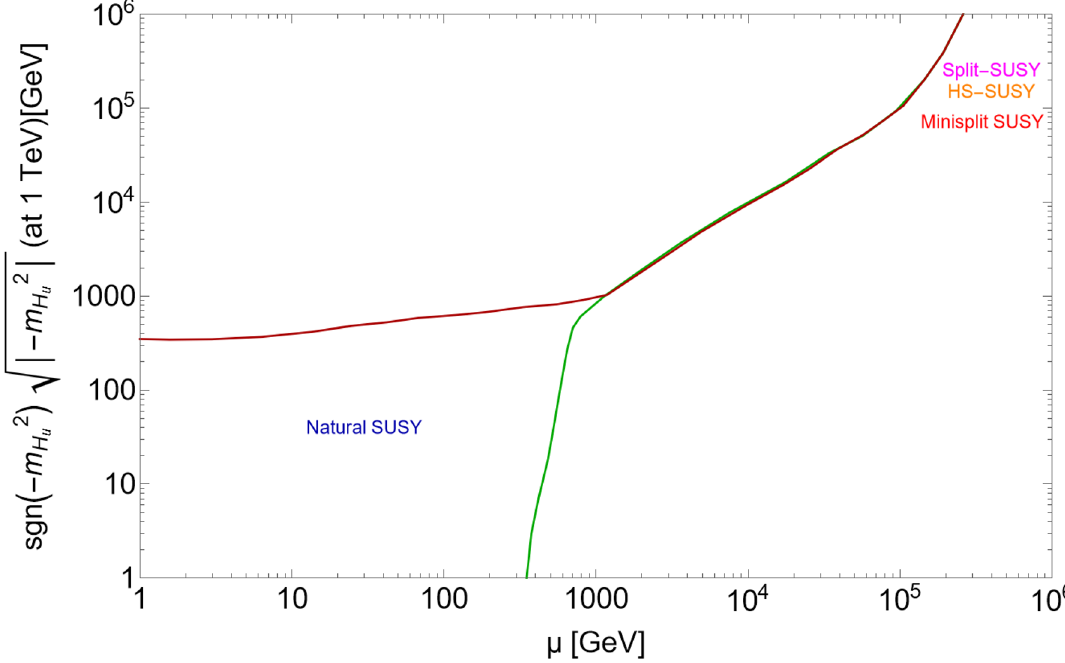
q − m 2 ( weak ) parameter space in a toy model ignoring radiative corrections H u